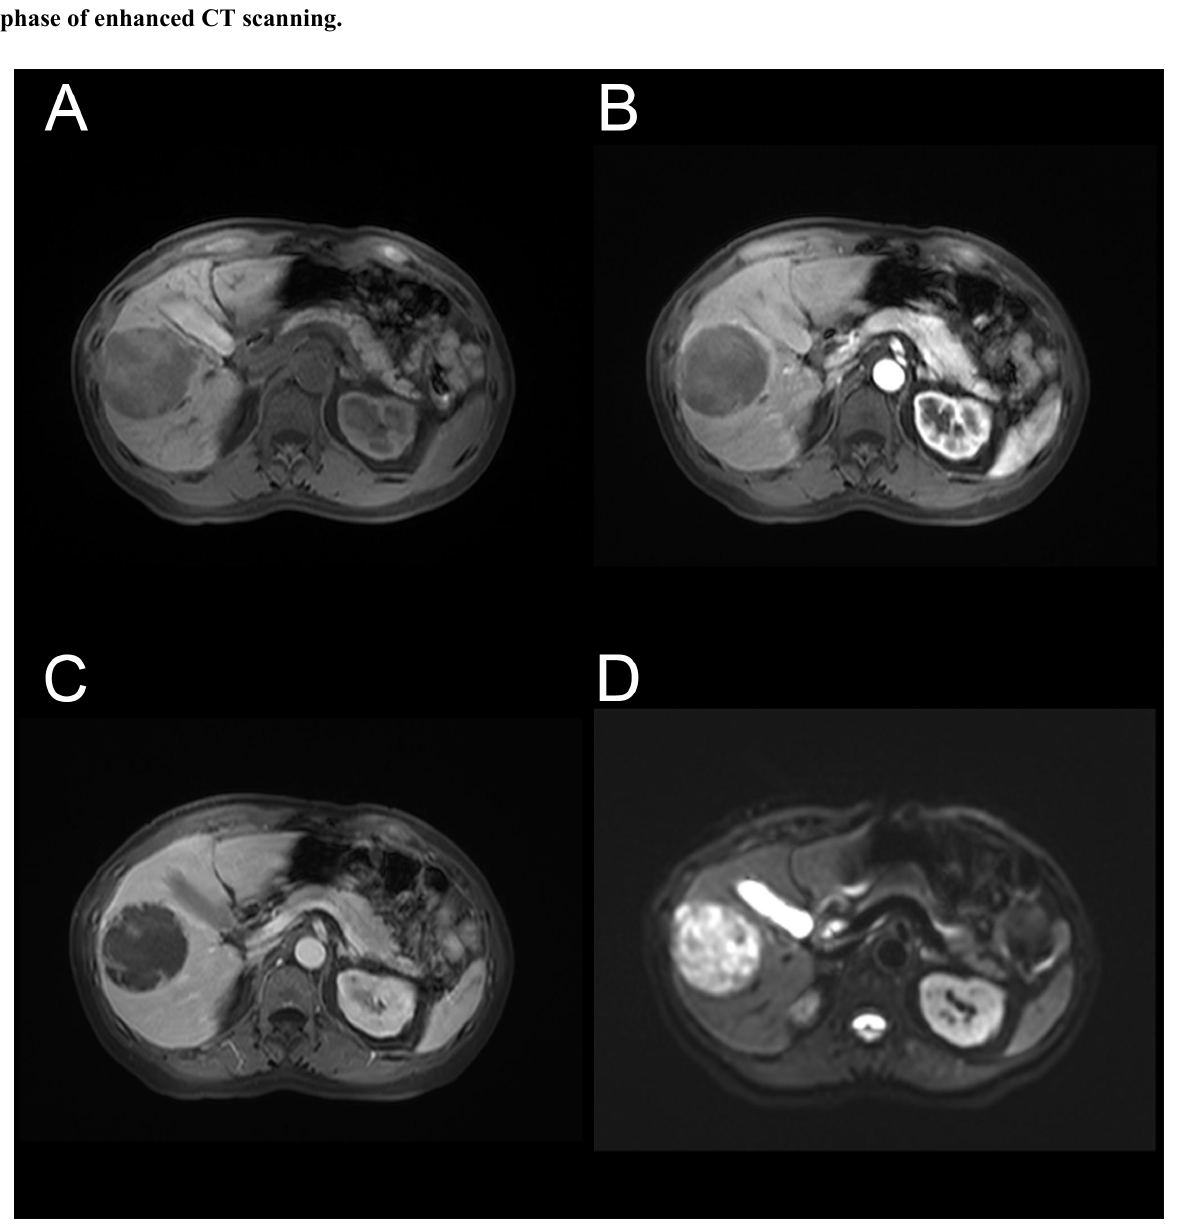
FIGURE 2. Preoperative MRI evaluation. (A) T1 weighted scanning. (B) Artery phase of enhanced MRI scanning. (C) Portal vein phase of enhanced MRI scanning. (D) DWI